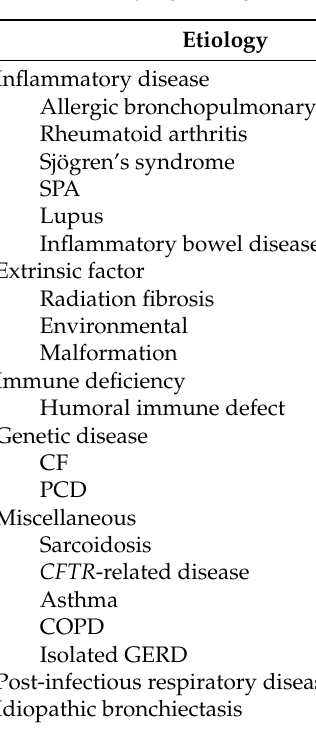
Table 3. Underlying etiologies in the validation cohort ( n =